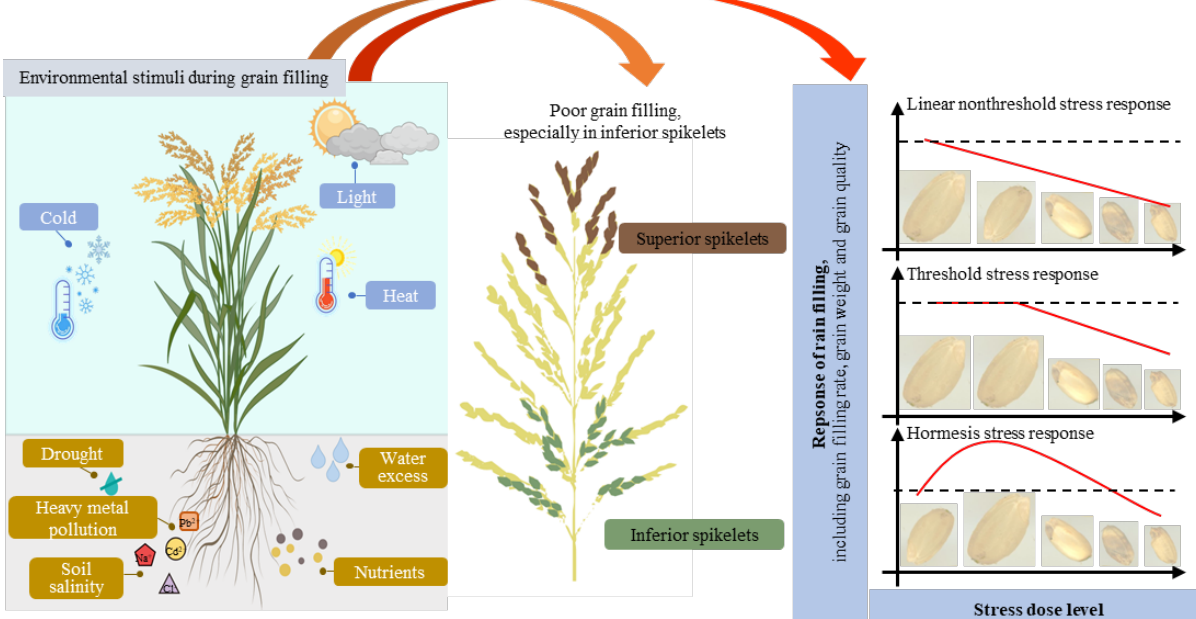
Figure 1. Environmental stimuli and cereal response during grain filling. Cereals are continuously exposed to different environmental stimuli (e.g., light, heat, cold, drought, and soil salinity) above- and belowground. Stress dose–response relationships in grain filling are categorized based on their responses to the stress dose level into linear nonthreshold stress response, threshold stress response, and hormesis stress response [45,46]. The dashed line indicates the control. This figure was created with the help of Figdraw (www.home-for-researchers.com, accessed on 1 November 2022). 2.2. Stress Dose–Response Relationships in Grain Filling It is generally believed that the process of grain filling is synergically determined by genetic and environmental factors, in which the latter are the key factors [3,47]. Fully un- derstanding the responses of grain filling under environmental stimuli might provide key solutions to problems in agricultural production under unfavorable environments (Table 1). Light, temperature, water, and fertilizer are the main environmental factors and have adverse effects on grain filling, especially on inferior grains (Figure 1; Table 1). Superior grains located on apical primary branches usually flower earlier and produce larger and heavier grains, while inferior grains located on the proximal secondary branches are pol- linated later and generate smaller grains [48]. Compared with superior grains, inferior grains need more time and energy for grain filling. It is for these reasons that inferior grains are more sensitive to environmental stimuli (Figure 1) [49]. For example, low light and shading inhibit starch synthesis in grains and thereby lead to poor grain filling, par- ticularly for the bottom part of the panicle [18,50]. Overuse of chemical fertilizer (espe- cially nitrogen fertilizer) highly influences the grain filling rate and quality of rice grains [19,51]. Heat stress and water deficit stress reduce the grain weight through a reduction in grain growth duration and grain growth rate, which is more serious in inferior grains [27,52–55]. However, mild soil drying can enhance whole-plant senescence, lead to the remobilization and transfer of assimilates pre-stored in vegetative tissues to grains, in- creasing the grain filling rate and grain weight of inferior spikelets [3,56,57]. Poor grain filling caused by saline–alkali stress is another key reason for yield loss in many rice cul- tivars [15,16]. The inhibitory effect by NaCl is also greater in basal spikelets than in apical spikelets [15]. These effects on inferior grain caused by environmental stimuli notably vary from year to year and lead to variations in the grain weight of cereals. It is therefore important to enhance inferior grain yield in adverse environments to improve and stabi- lize yield.